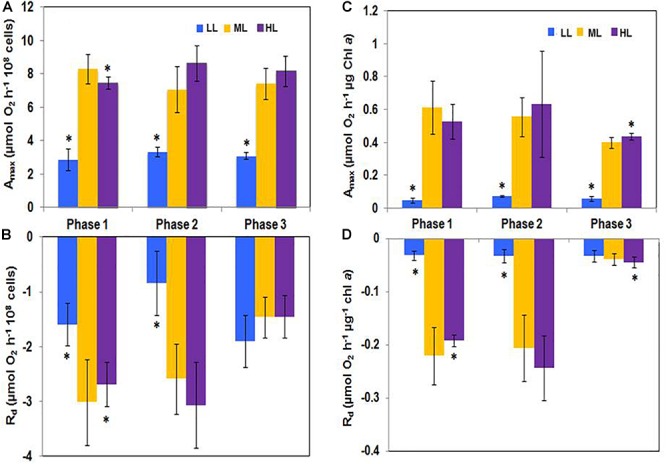
(A,C) Net photosynthesis (Amax) and (B,D) respiration (Rd) activities in Phaeodactylum tricornutum grown under different light intensities. Amax and Rd were significantly higher under ML and HL than under LL. However, their values did not change along the growth at any of the grown photon flux densities. Under LL, Amax was reduced while respiration was high, staying, however below. Values represent the mean ± SE (n = 3) and error bars represent SD. Means followed by asterisks are significantly different from the corresponding value in ML (p < 0.05).